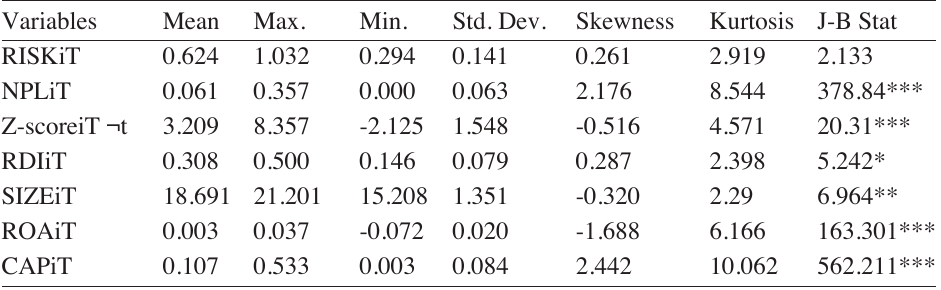
Table 1: Summary